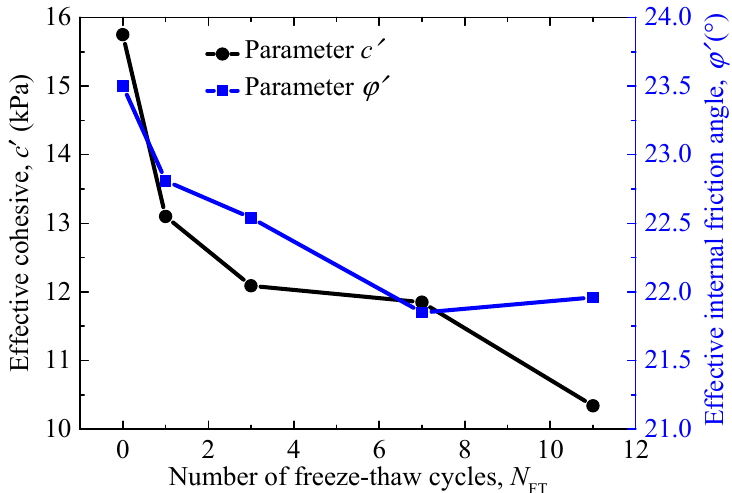
Figure 17. Cross-section of soil slope with cracking regions. The effective cohesion ( c ′ ) and effective internal friction angle ( φ ′ ) obtained from the laboratory tests are plotted in Figure 18 with respect to the number of F-T cycles ( N FT ). We note that both c ′ and φ ′ decrease with increasing N FT , indicating that the shear strength of the soil decreases with increasing N FT .